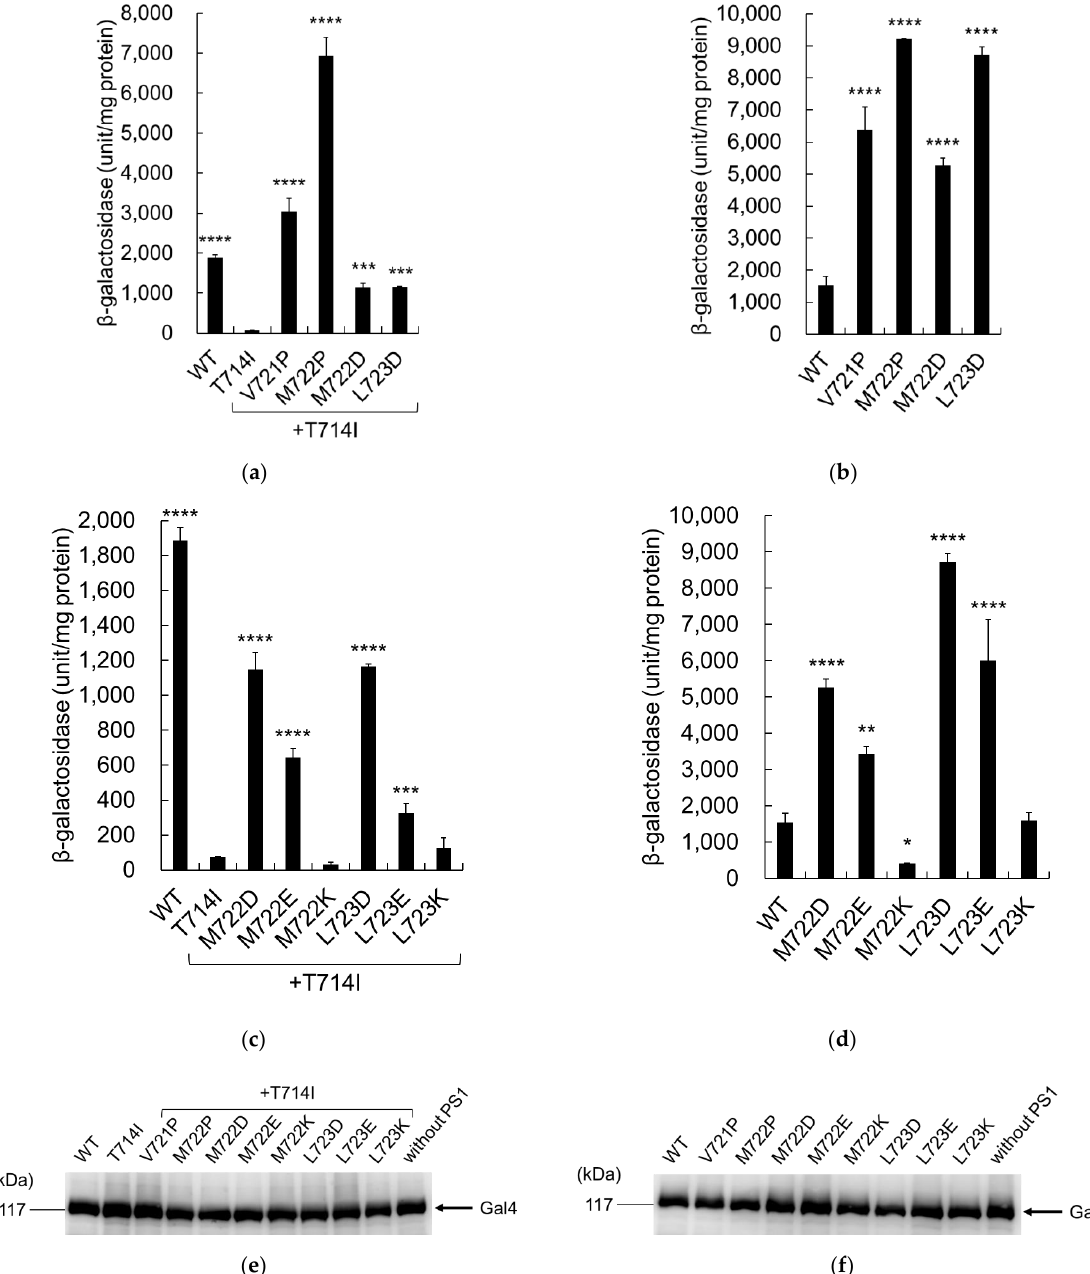
Figure 5. β-Galactosidase activity of APP proline and aspartate mutants. ( a – d ) β-Galactosidase activity was assayed for each cell expressing either WT or mutant APPC55-Gal4p, as in Figure 3. Activity was normalized to that of the control cells without PS1 (61 units/mg protein for ( a , c ) and 63